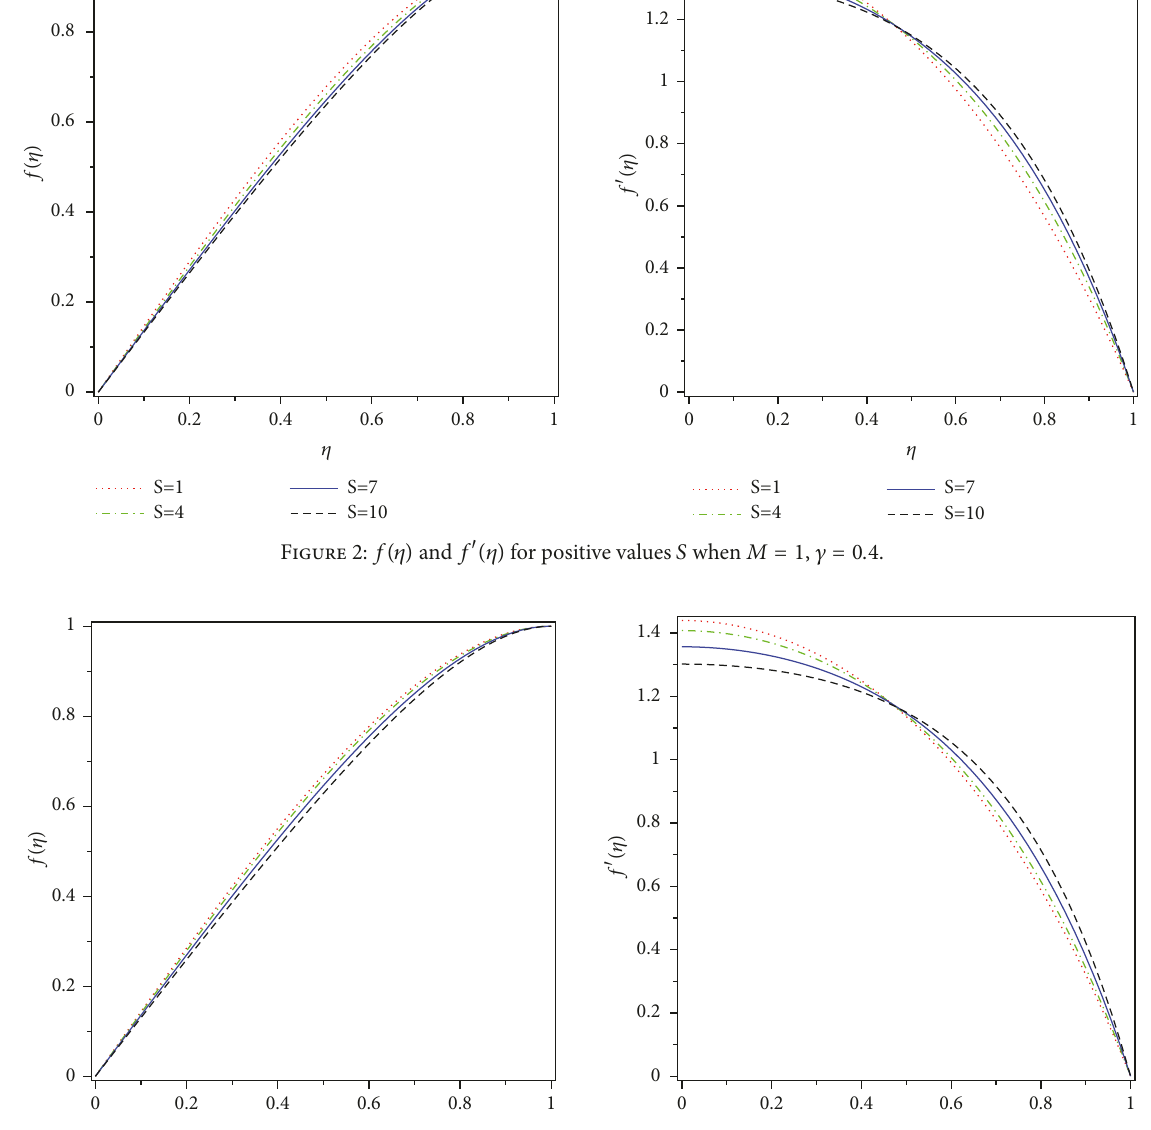
and V (𝑥, 𝑦, 𝑡) with noticing that the surface V (𝑥, 𝑦, 𝑡) slightly changes when 𝑙 = 1 in Figure